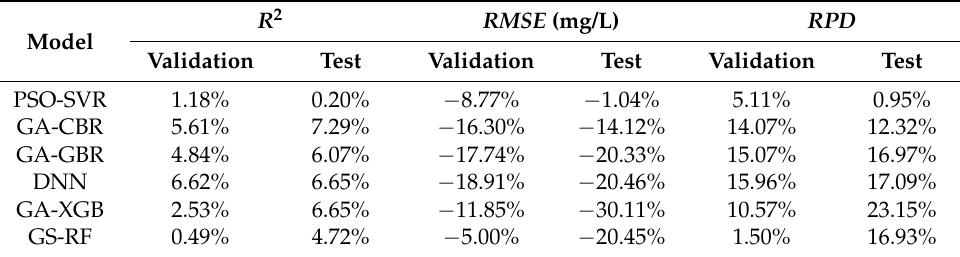
Table 6. Improvement of the six IOA-ML models with feature amplification and